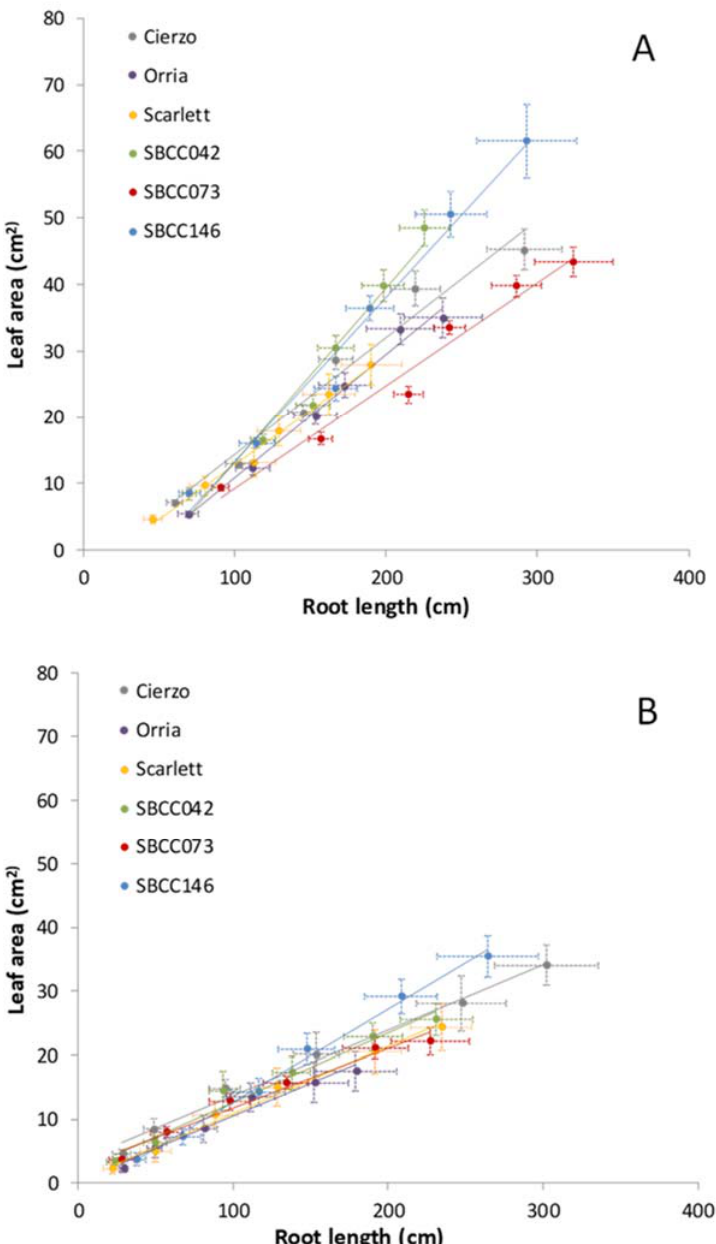
Figure 3. Total root length vs leaf area under control ( A ) and drought ( B ) conditions. Bars represent ± standard error of the mean of variables represented on both axes.